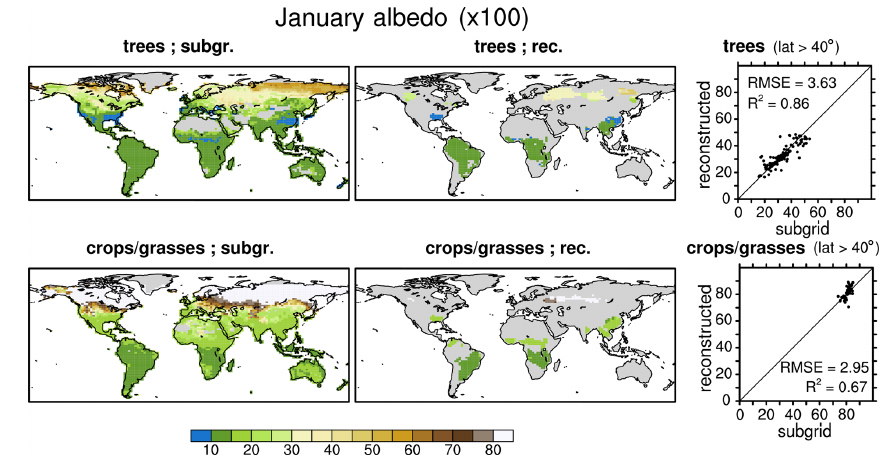
Figure 3. Same as Fig. 2, but for the month of January. The scatter plots in this case only display the results for the grid cells north of 40 ◦ (i.e. over areas considered snow-covered). Note that the scale is different.